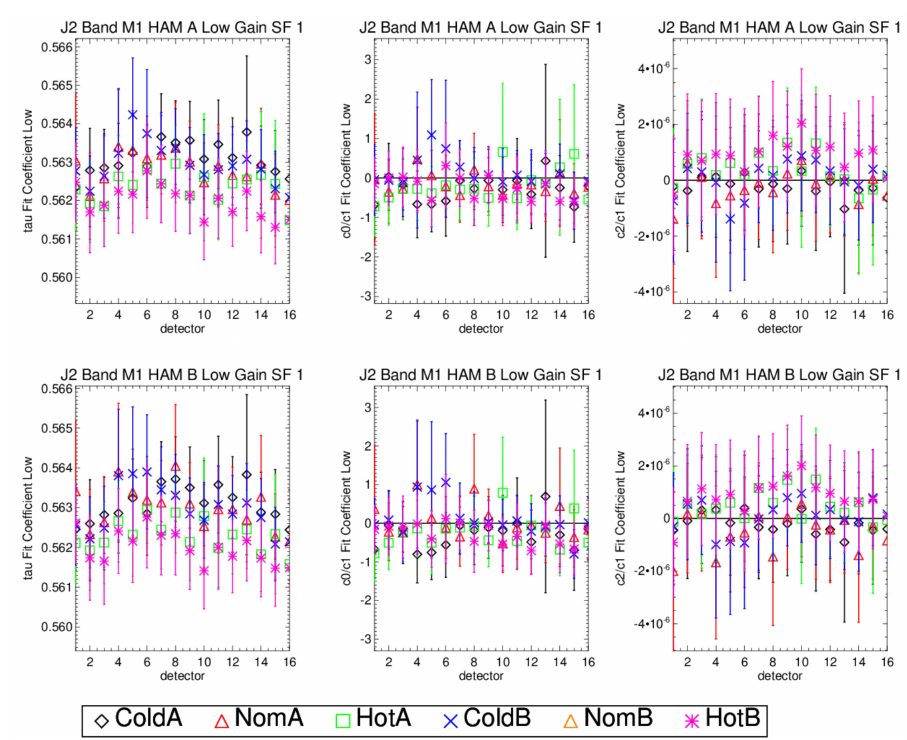
Figure 9. Band M1 low gain fit coefficients for all detectors (x-axis) and TVAC/electronics configurations (colors and symbols). The columns are tau, c 0